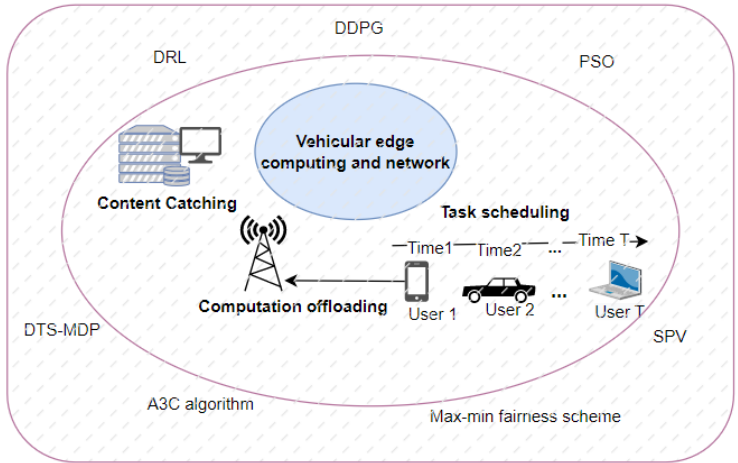
Figure 3. Operation of